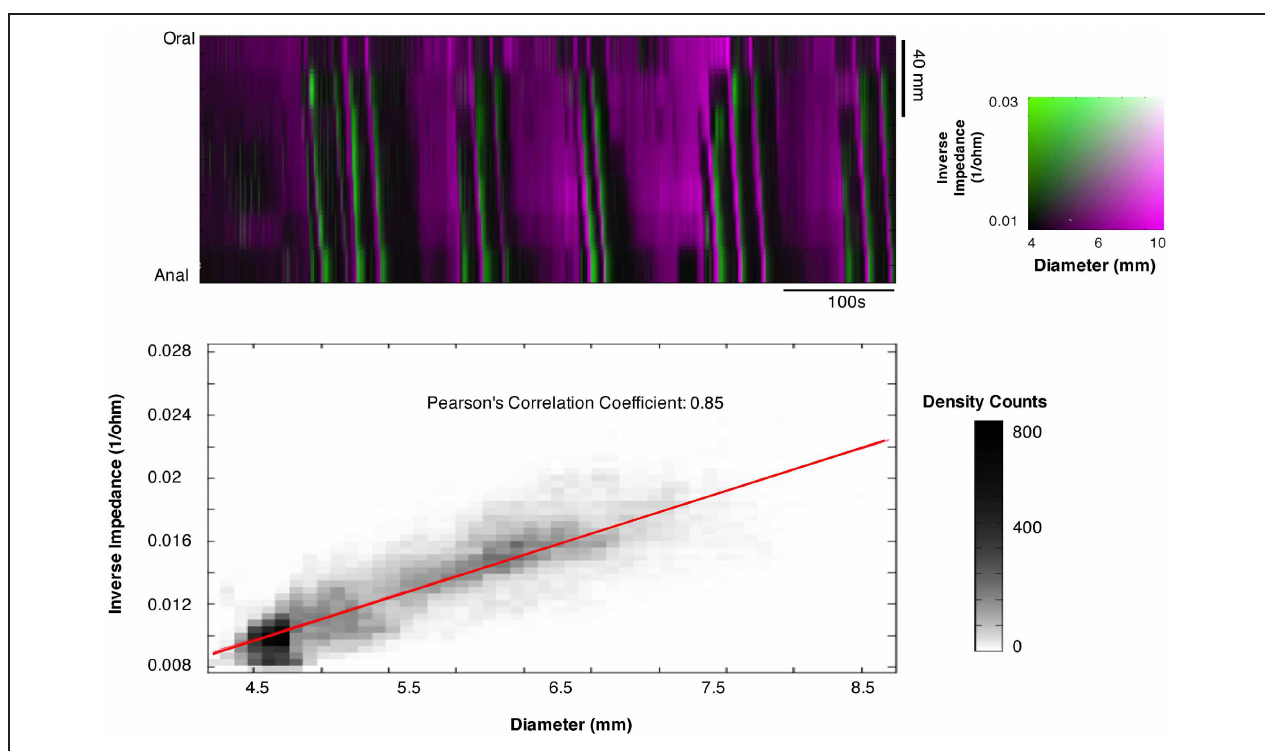
FIGURE 11 | Composite impedance/diameter map (IDMap). The map displays the inverse impedance (green), which is proportional to internal cross sectional area of the gut and the diameters from video recording DMap